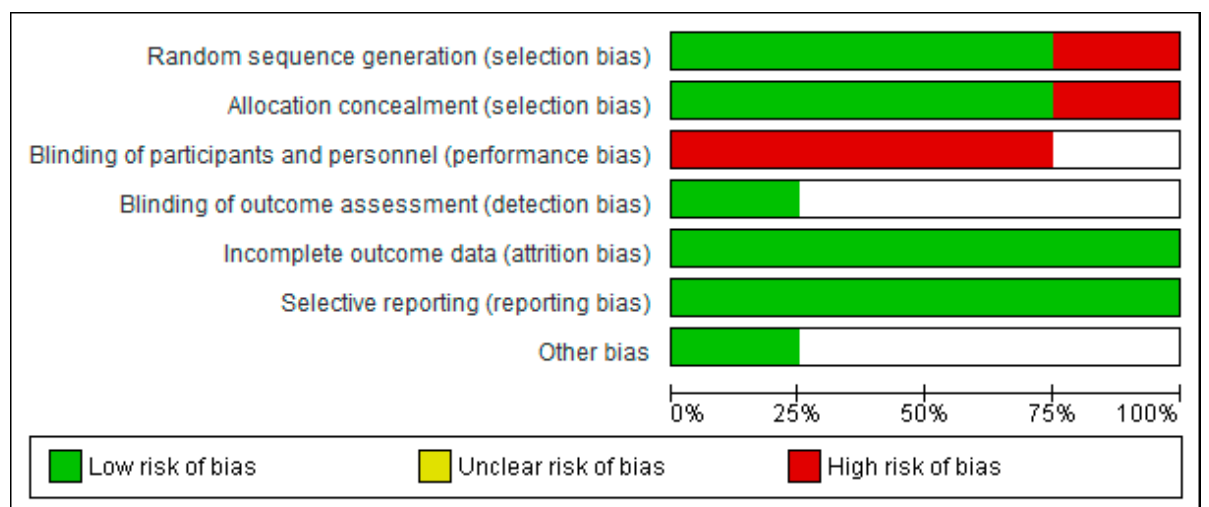
Figure 1. Flow chart of the databases searches on the influence of vaginal interventions on vaginitis and vaginal atrophy after brachytherapy or radiotherapy in patients with malignant endometrial or cervical tumors.